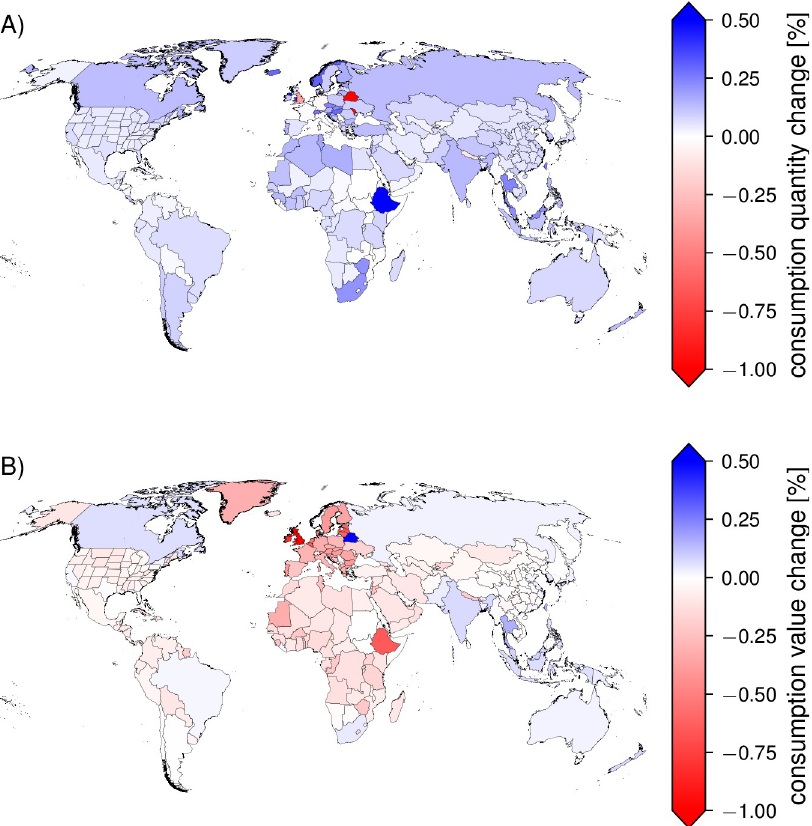
Fig 5. World map of consumption quantity and value changes after 30 days of a no-trade-deal event. Shading of colors is according to consumption quantity (panel A) and consumption value (panel B) changes after 30 days of reduced border permeability. Underlying scenario assumes 70% border permeability. Changes in consumers’ prices are shown in S3 Fig in S1 File.